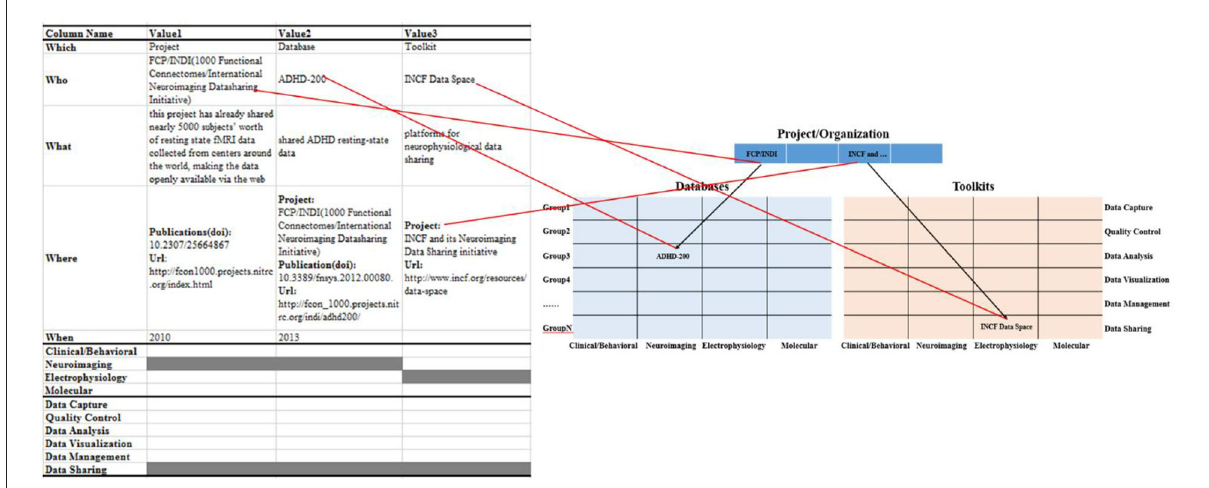
FIGURE3 Map information objects to a hierarchical knowledge base